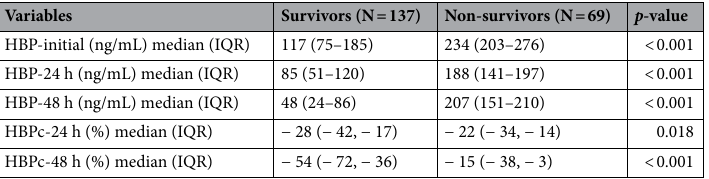
Table 2. Comparisons of HBP and HBPc dynamic monitoring levels between survivors and nonsurvivors in patients with sepsis or septic shock. HBP-initial, HBP level at admission. HBP-24 h, HBP level at 24